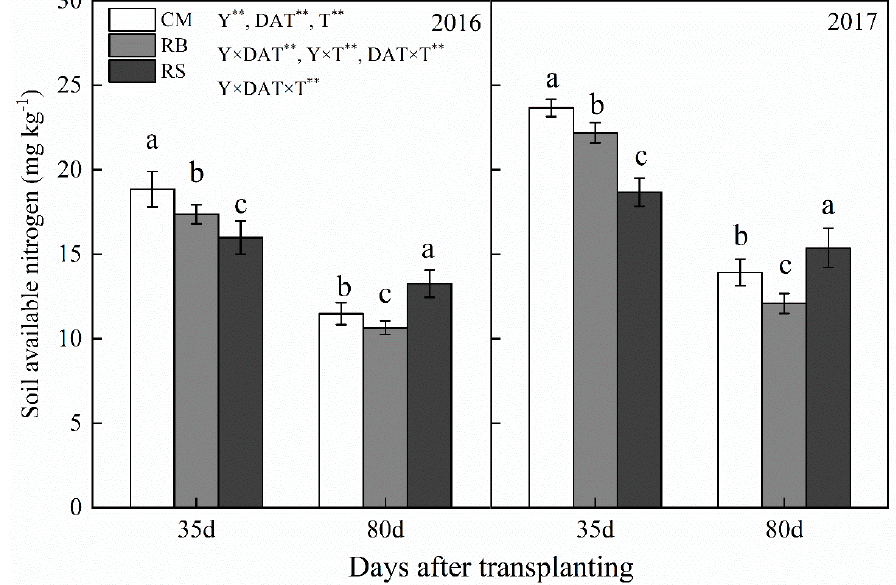
Figure 1. Soil AV-N levels of three N management strategies at soil depths of 0–20 cm in 2016 and 2017. Note: CM: conventional N management; RB: 20.0% reduced N was applied as basal; RS: split application of 20.0% reduced N at transplanting and 35 DAT. Y, year; DAT, days after transplanting; T, treatment. Values are the treatment means for a given management strategy within a particular year ( n = 3). Error bars represent the standard error of the mean. ** indicate significance at p < 0.01 probability level. The di ff erent lowercase letters in the same column indicate significant di ff erences at p ≤